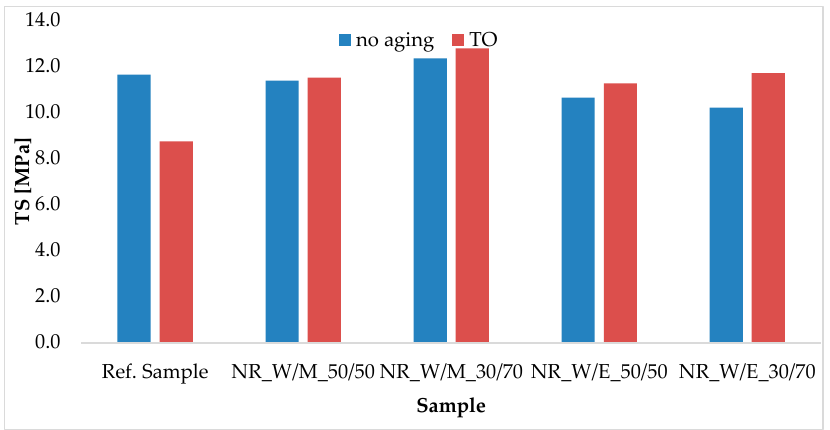
Figure 5. Tensile strength of vulcanizates before and after simulated thermo ‐ oxidative aging process. Table 6. Elongation at break of vulcanizates before and after simulated thermo ‐ oxidative aging process and aging factor (K). Before Aging